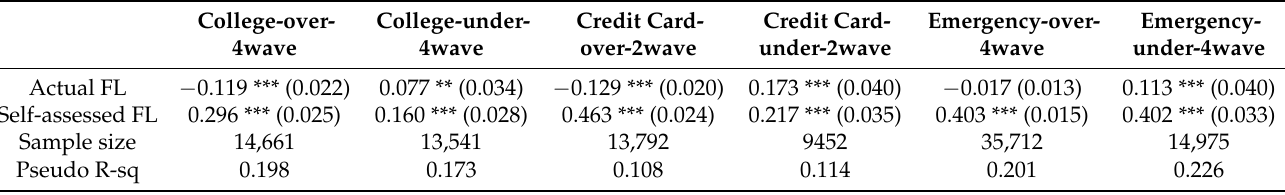
Table 5. Logistic estimation of financial planning